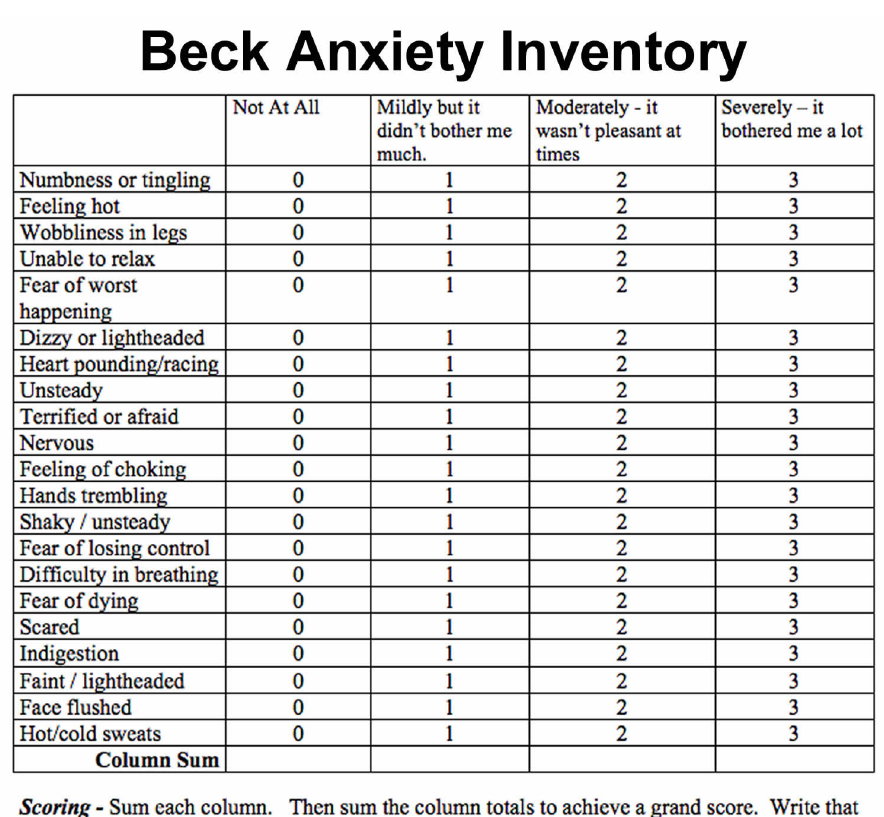
Figure 1. Jet anesthesia (JA) ( a ) Depicts the application of local anesthesia using the needleless. jet injection concerning the 14, 15 tooth region before periodontal therapy. ( b ) The adapter CAP01 is placed at 90° on the attached gingiva and a shot of infusion is achieved.